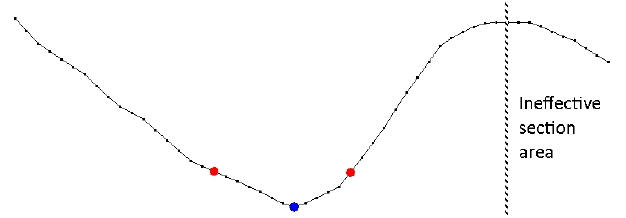
Figure 30. Removal of ineffective areas.